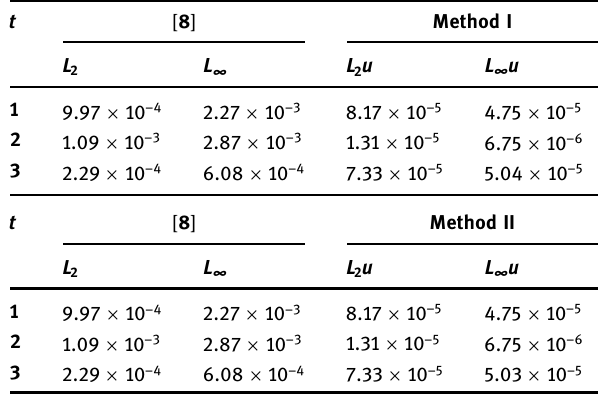
Table 13: Comparison of errors at = t 1 , 2, and 3 for = N 21 , = t Δ 0.0001 , and = τ 0.5 regarding Example 5 t [ 8 ]